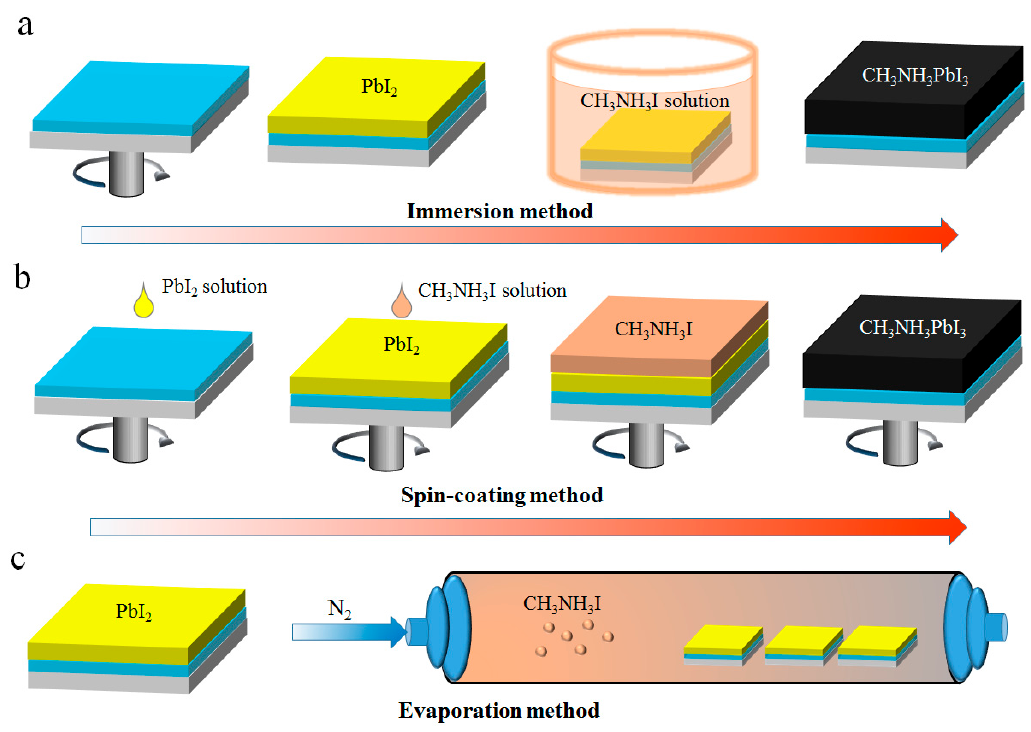
Figure 1. Schematic diagram of different types of two-step methods: ( a ) immersion, ( b ) spin-coating, and ( c ) evaporation two-steps methods for the fabrication of perovskite film.